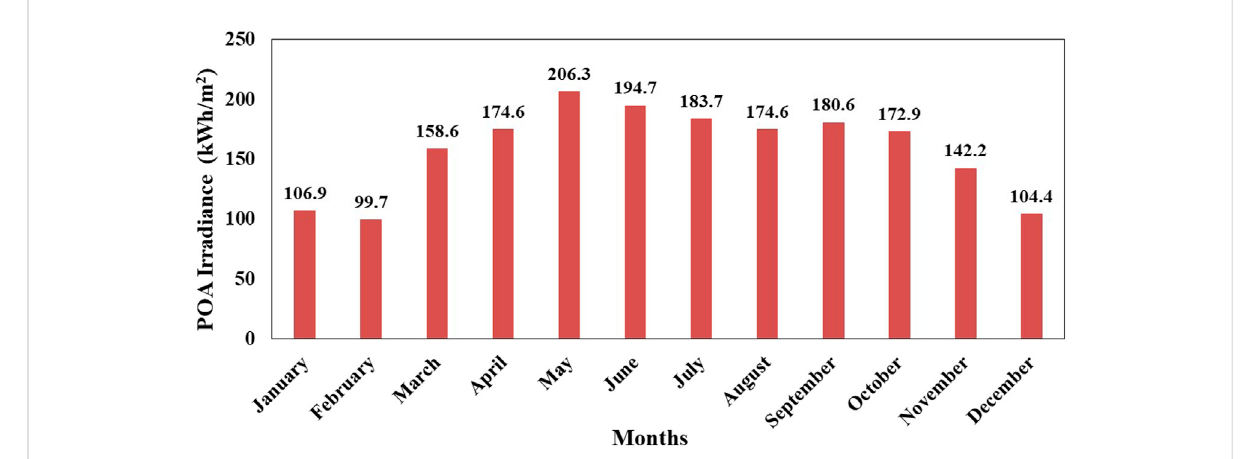
FIGURE 7 Plane of the array (POA) irradiance.